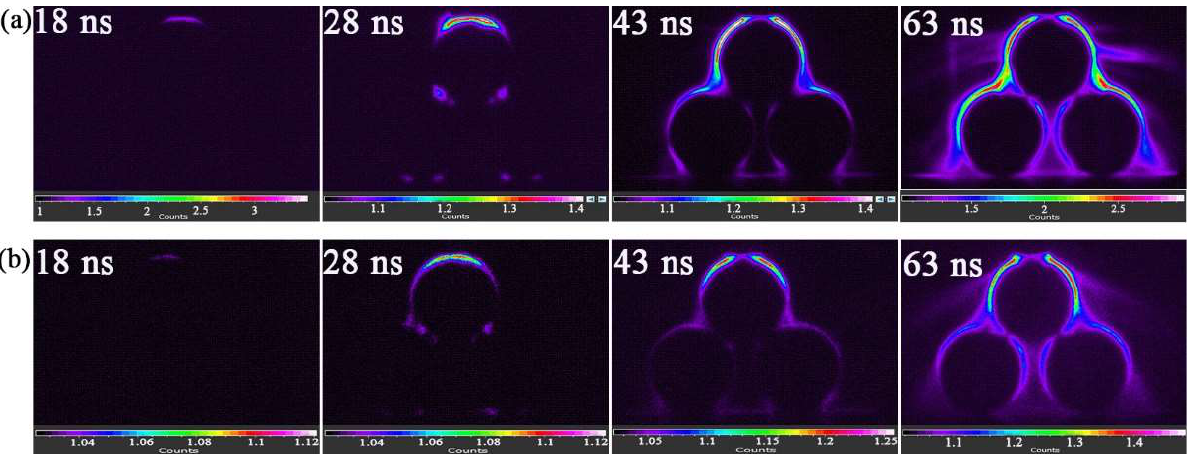
Figure 7. ICCD images of the discharge evolution processes during the rising time of the voltage pulse in ( a ) pure nitrogen and ( b ) air.